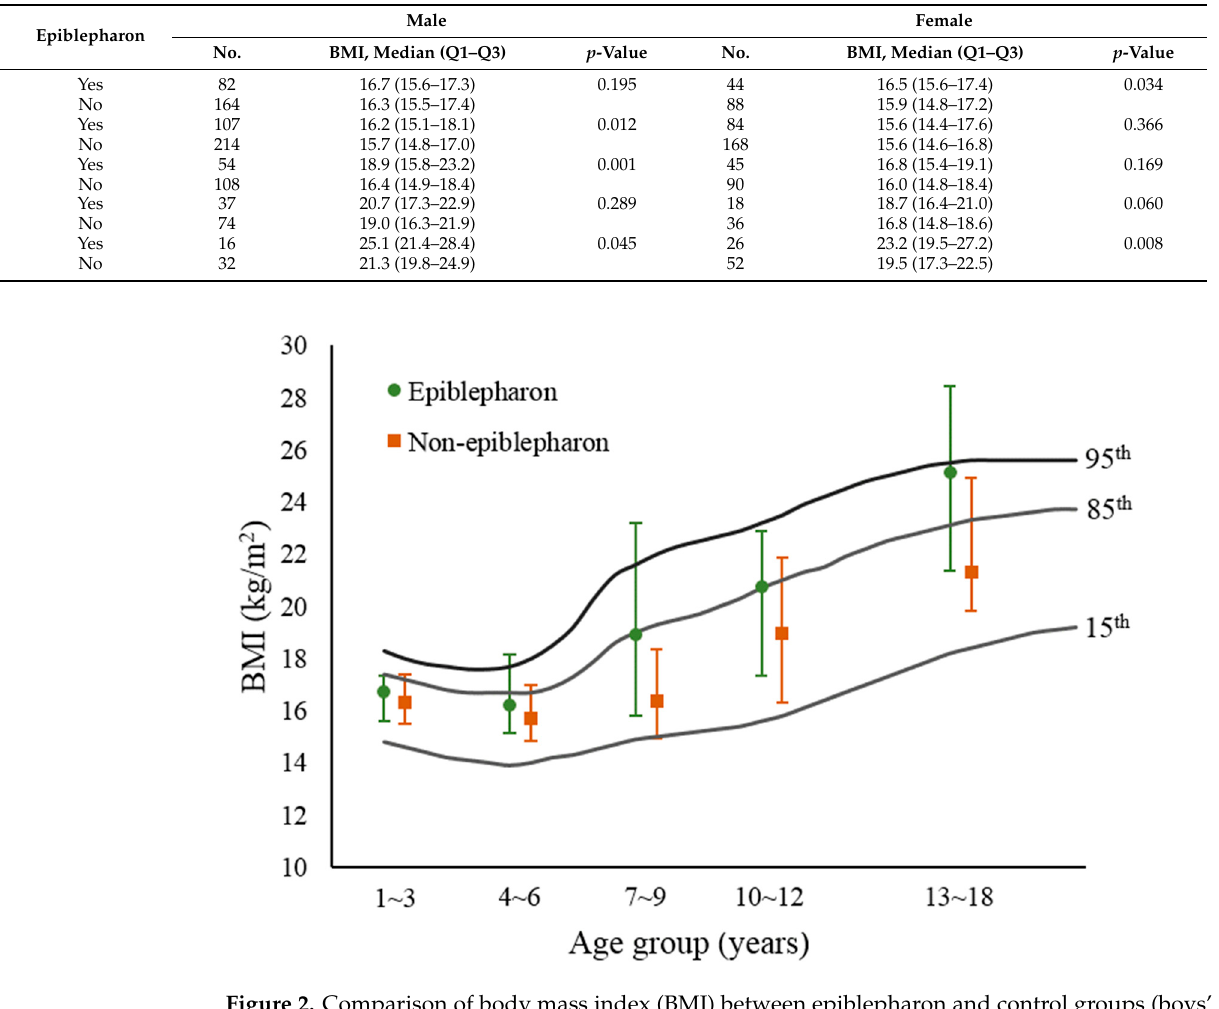
Figure 2. Comparison of body mass index (BMI) between epiblepharon and control groups (boys’ group). The background chart is the BMI-for-age growth curves by percentile, based on 2013 Taiwan standards. Table 3. Odds ratios (OR) between epiblepharon and overweight/obesity by sex and